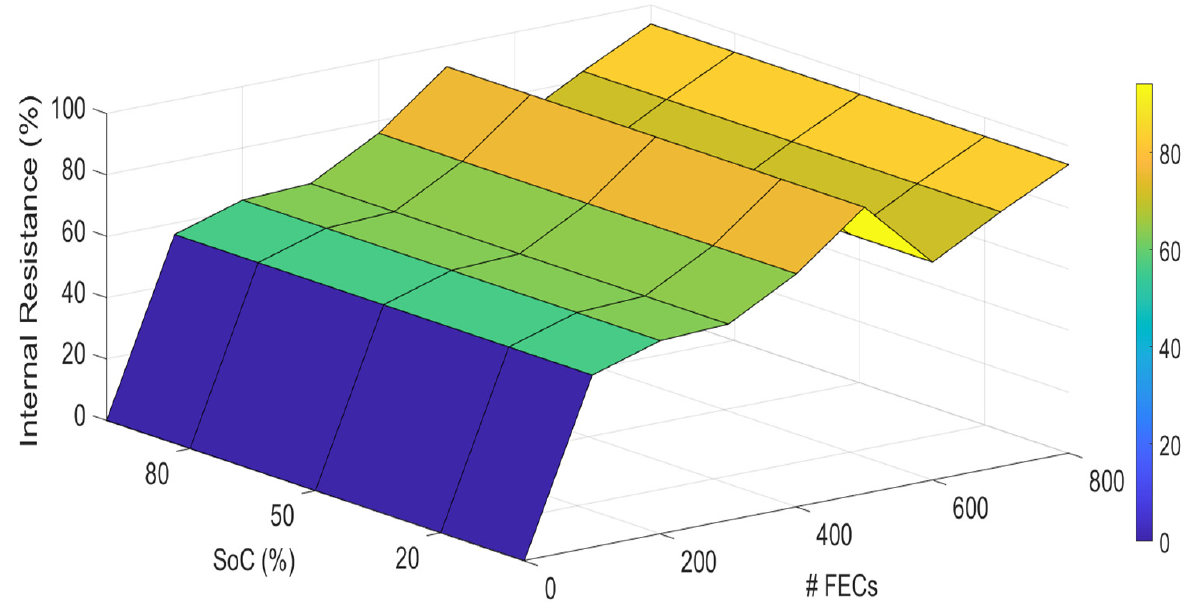
Figure 12. Internal resistance versus SoC relationship with 3D surface fitting.